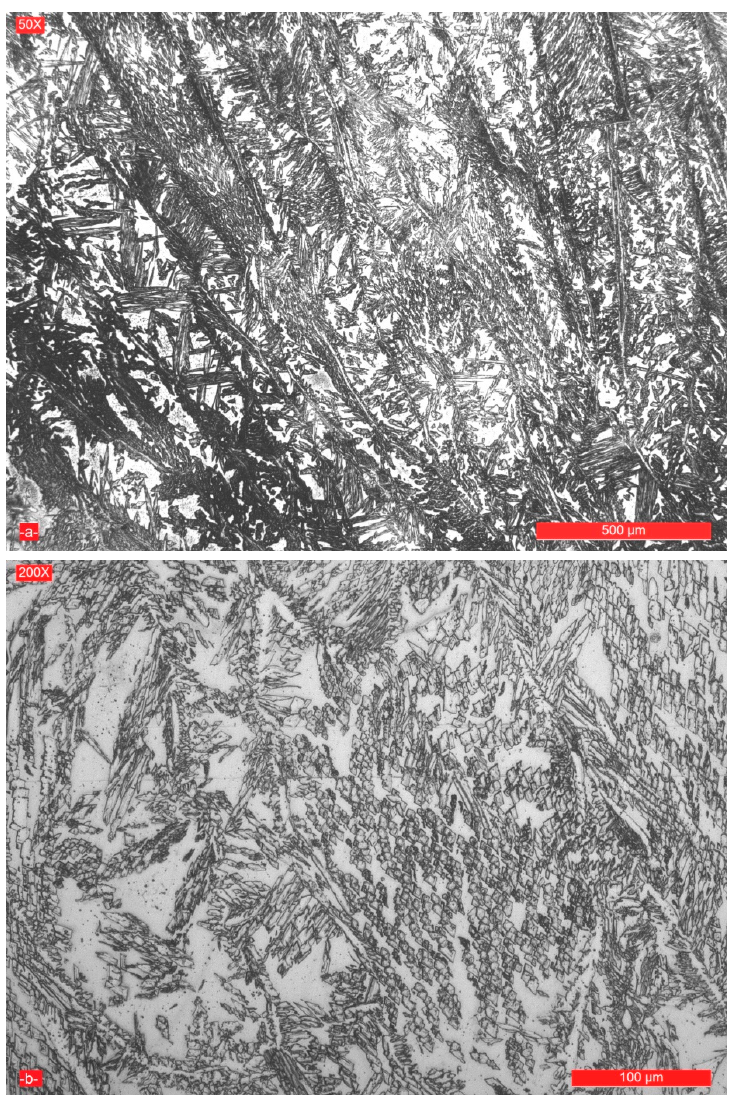
Figure 7. Microstructure of the last deposited layer for achieving the welded joint with a linear energy E l = 15 kJ/cm: ( a ) magnification 50×; and ( b ) magnification 200×.